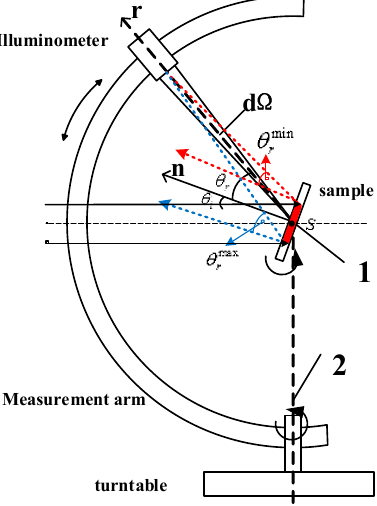
Figure 5. The right side of measurement device of solar panel.